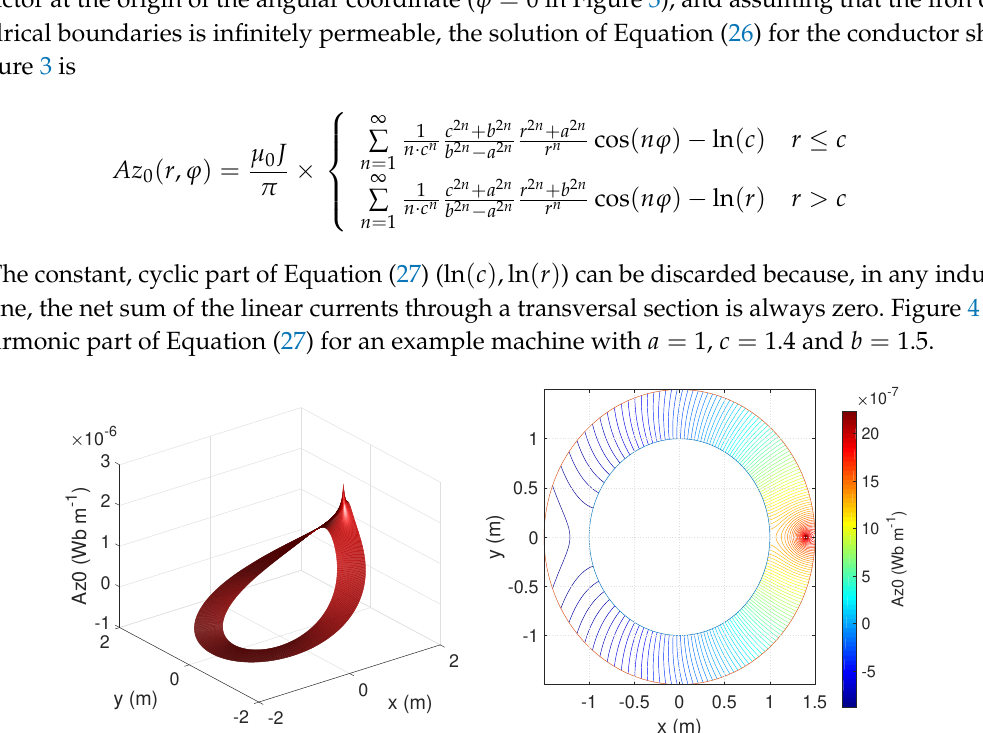
Figure 4. ( Left ) MVP that produces in the air-gap an axial conductor located at ϕ = 0 and r = c when fed with a 1A current; and ( right ) induction lines in the air-gap.